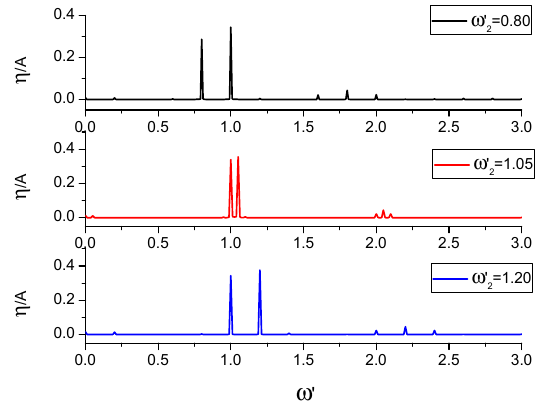
Figure 10. Amplitude spectral analysis of wave runups of heave motion with two frequencies.